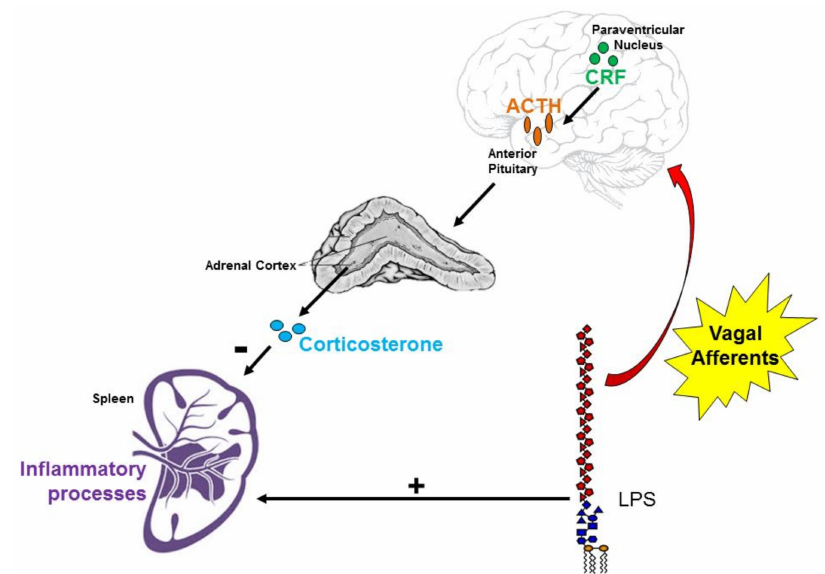
Figure 1. The vagus nerve is a conduit between the brain and immune system. Vagal afferents transmit information regarding peripheral inflammatory processes (such as lipopolysaccharide (LPS) challenge, which also induces the release of pro-inflammatory cytokines by splenic macrophages and other innate immune cells) to the nucleus tractus solitarius. This causes corticotropin releasing factor (CRF)-releasing parvocellular neurons in the paraventricular nucleus (PVN) of the hypothalamus to prompt adrenocorticotrophic hormone (ACTH) release from the anterior pituitary. ACTH from the bloodstream then binds to receptors in the zona fasciculata of the adrenal cortex to induce corticosterone release. Plasma corticosterone inhibits initiation of the inflammatory